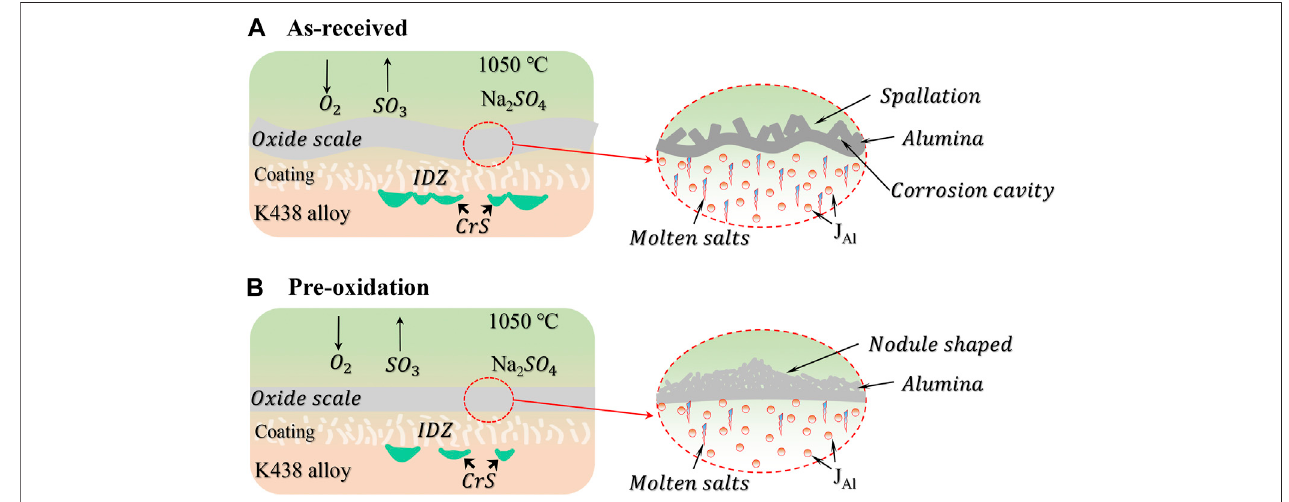
FIGURE 12 | A schematic illustration of corrosion mechanism of aluminide coating for (A) as-received and (B) pre-oxidation.